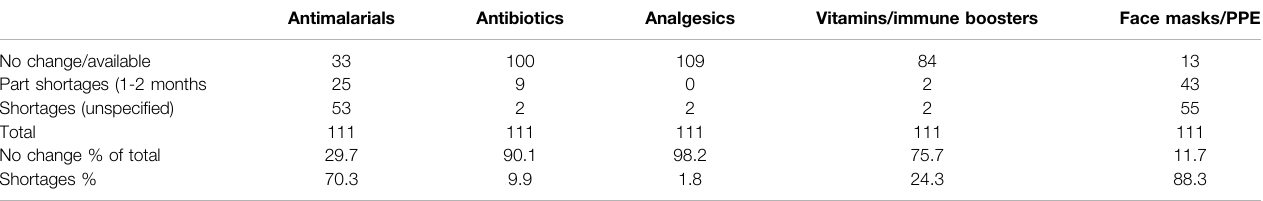
TABLE 6 | Shortages for medicines and PPE between beginning March 2020 and end May 2020 among 111 pharmacies in